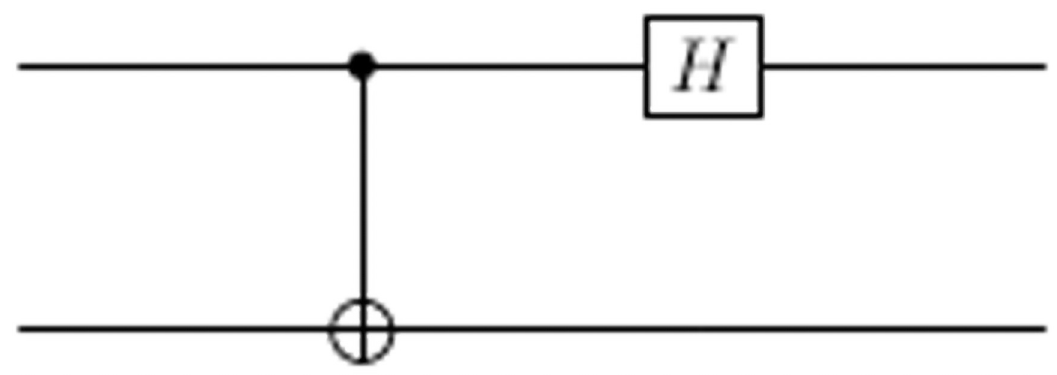
Fig 3. Circuit to decode Bell states to